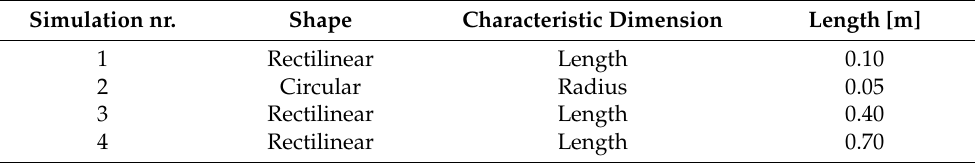
Table 4. Simulated trajectories.